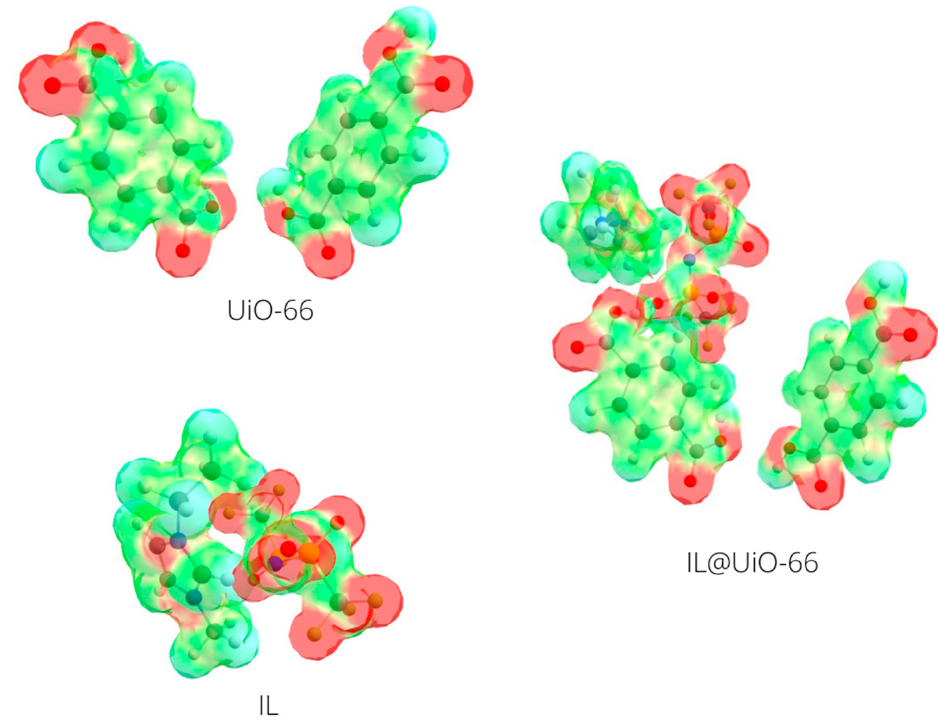
Figure 18. The molecular electrostatic potential isosurface of UiO-66 linkers and [EMIM][TFSI]. Red color represents the attraction of the atom by the concentrated electron density in the molecules, blue color represents the repulsion of the atom by the atomic nuclei in regions where low electron density can be found, and the nuclear charge is incompletely shielded. The contour value was set to 0.1, and the value range was set from − 0.1 to 0.05.